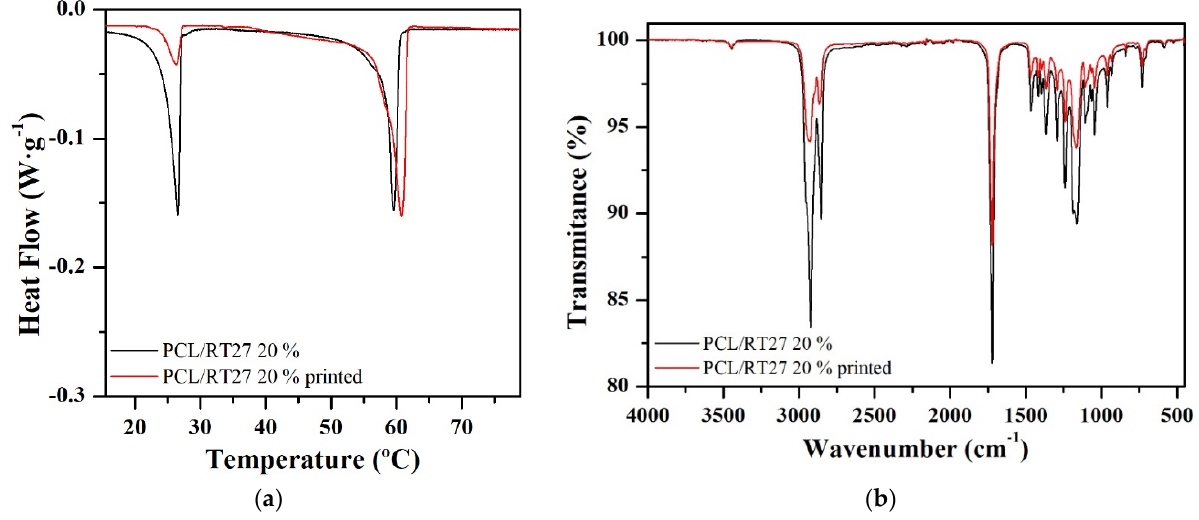
Figure 14. PCL/RT27_20% blend ( a ) Heat flow curves before and after the printing step; ( b ) FT-IR spectra before and after the printing step.